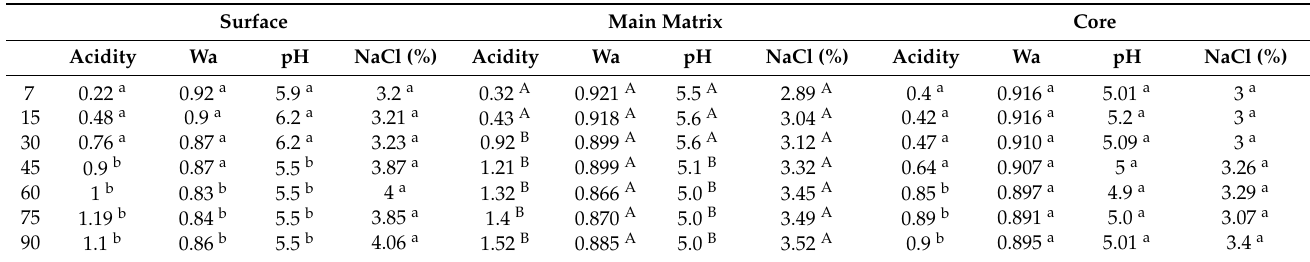
Table 4. Physicochemical parameters during the cheese maturation